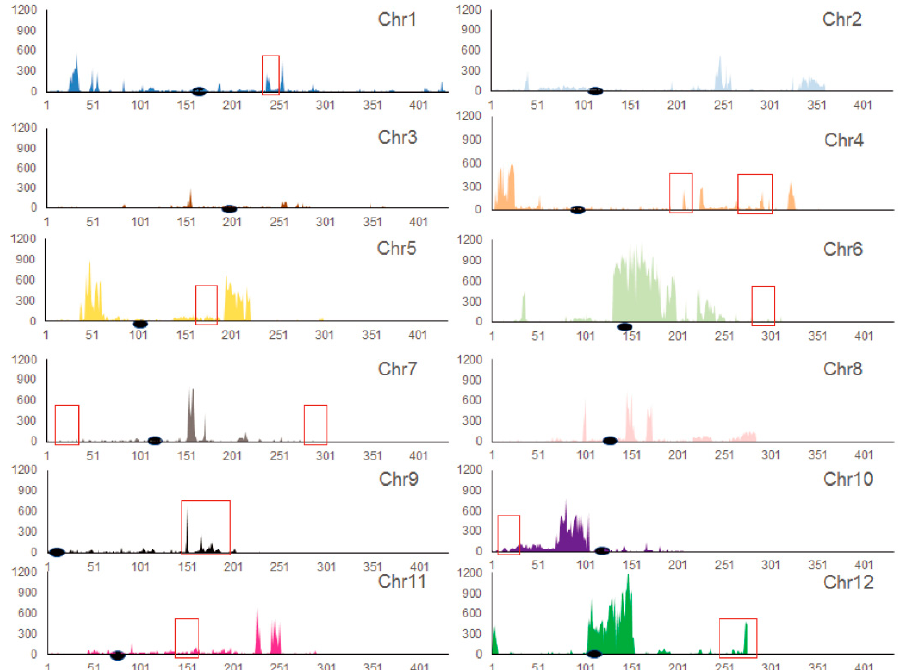
Figure 3. Distribution of SNPs within 100-kb windows across each chromosome. Different rice chromosomes (Chr-12) are indicated in different colors. The X-axis represents the length of each chromosome divided by 0.1 Mb. The Y-axis indicates the number of SNPs. Black solid ellipse represents the centromere. Red frames indicate the domestication-related regions identified in japonica rice [28].